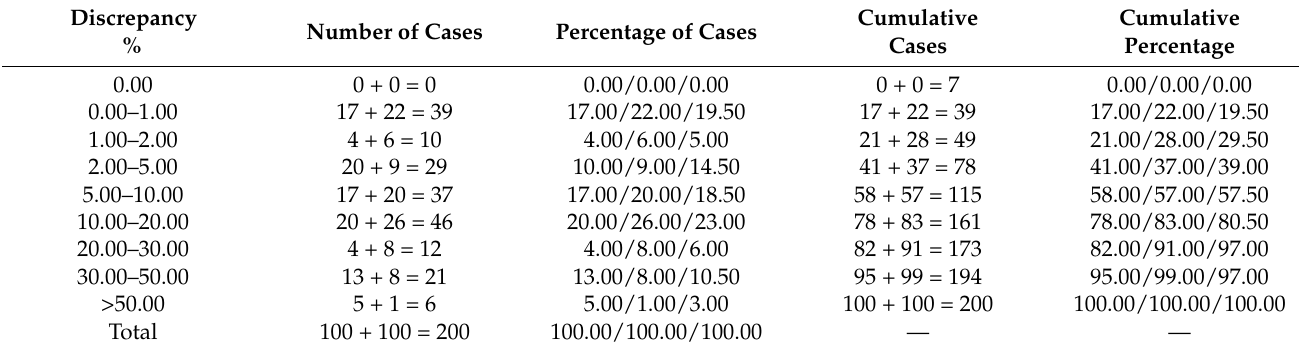
Table 33 for landing flight conditions appear in Table 34 for takeoff flight conditions, for example, error of less than 5% for 78 cases (39.00%) out of a total of 200, less than 10% for 115 cases (57.50%), and less than 20% for 161 cases (80.50%). Most stability derivatives were estimated with accuracies of 10% or better using the simple extrapolation factors provided. Table 34. Comparative accuracy of extrapolation and CFD–RANS (takeoff).